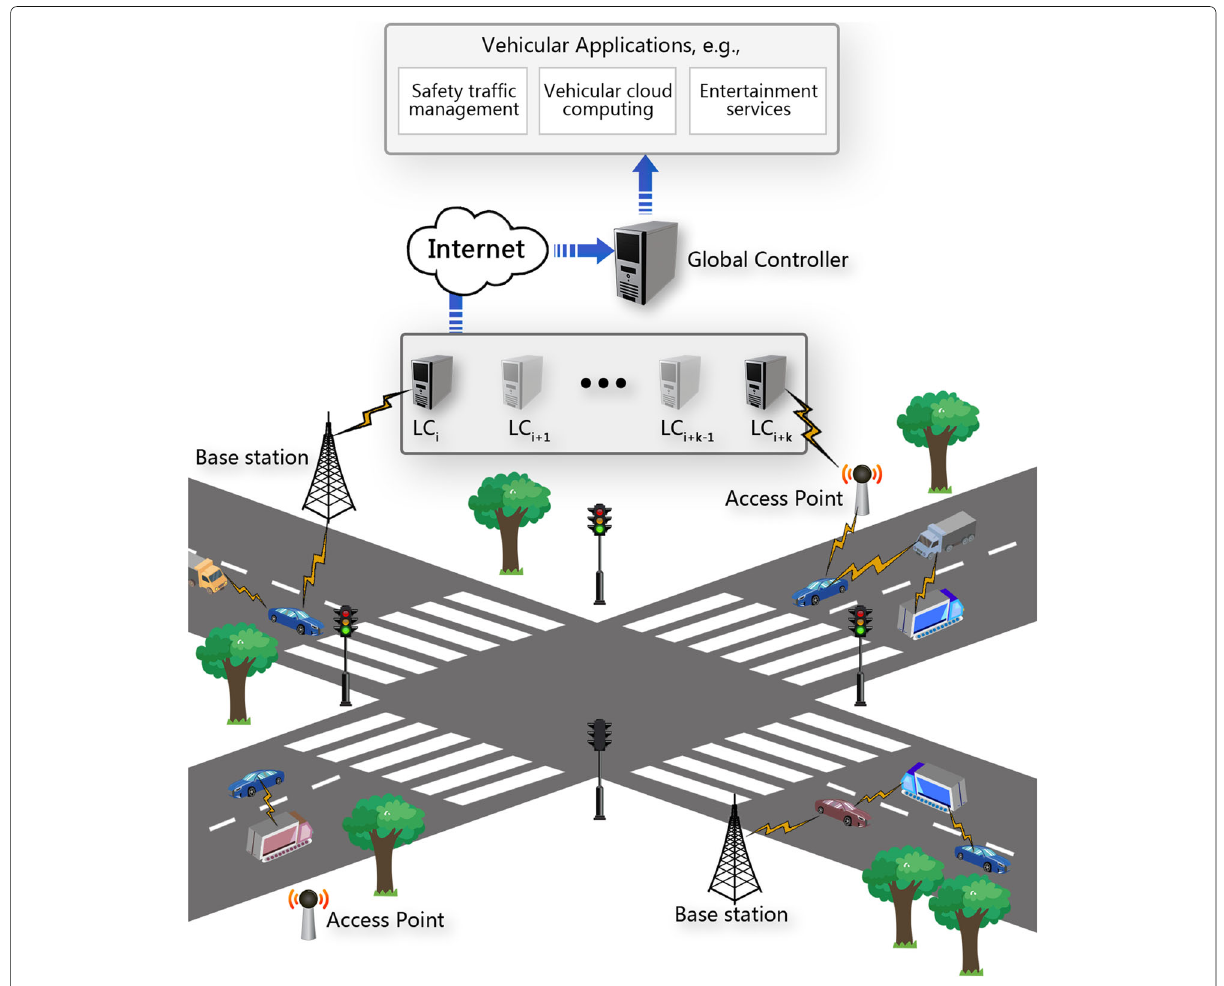
Fig. 1 The system model of the proposed scheme requires a quite long period to deploy, and the cost may be unaffordable for some users. So the coexistence of different types of networks is necessary. 5 TM: Transport manager is the vehicle-managing authority. It would notify and warn vehicle owners when their vehicles’ weight values drop below a specific threshold